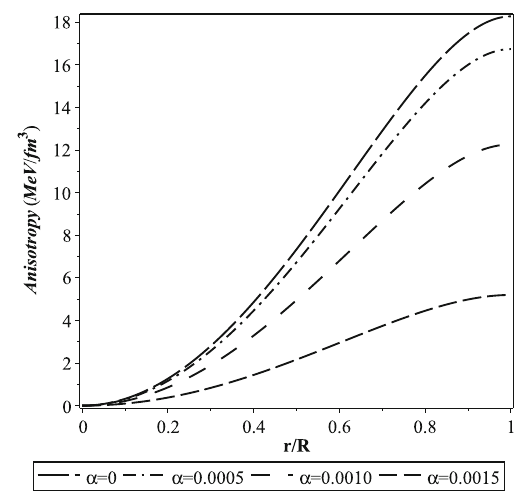
Fig. 3 Variation of anisotropy as a function of the radial coordinate r / R for the strange star LMC X − 4